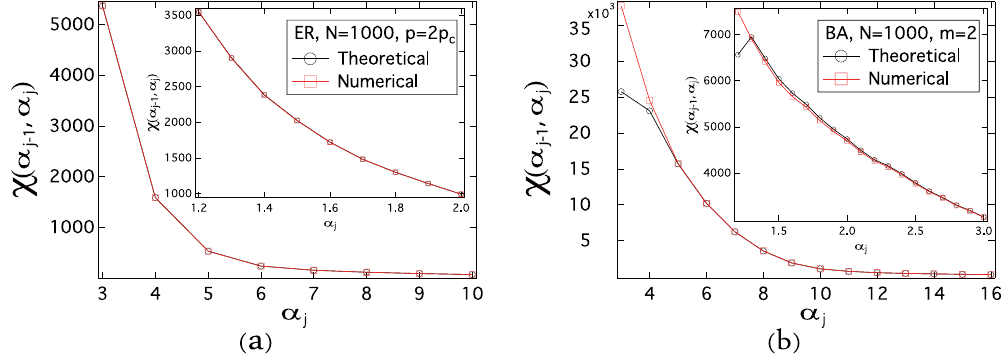
Figure 3. The number χ ( α j − 1 , α j ) of crossings as a function of the normalized effective infection rate α j . For ER graphs, we employ the link density p = 2 p c , thus the average degree E [ D ] = 14, the size N = 1000 and the NIMFA (1) τ ≈ . . For BA graphs, we employ the number of newly added links in each step epidemic threshold 0 0673 c m = 2, thus the average degree E [ D ] = 4, the size N = 1000, and the NIMFA epidemic threshold τ ≈ . 0 0902 The meta-stable infection probability v k ∞ is obtained by solving (11) and the number χ ( α j − 1 , α j ) of crossings is obtained by (1). The results are averaged over 10